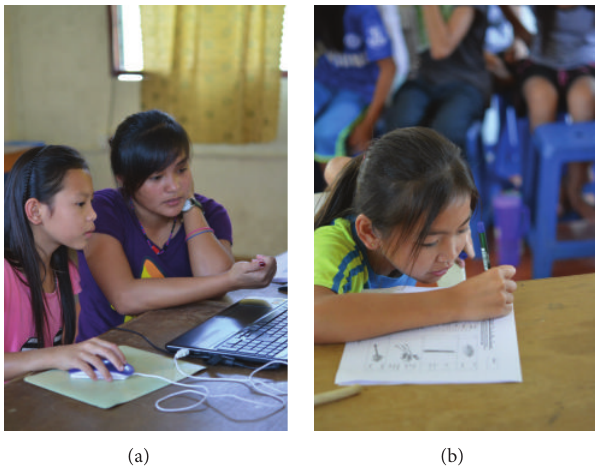
Figure 8: Users testing Oroo’ adventure